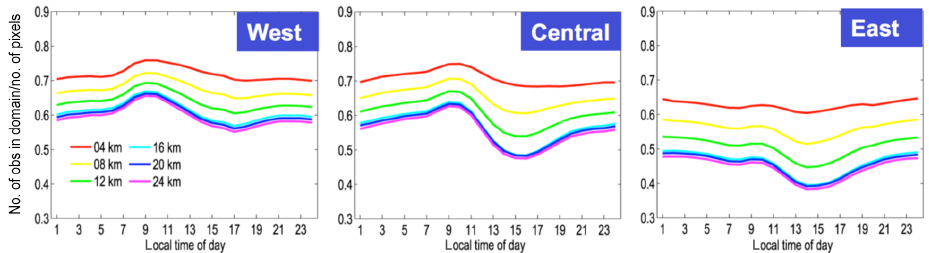
Figure 11. CONUS cloud statistics from OSSE results for 15–30 July 2006 using a high-spatial-resolution WRF-Chem run and a GFCR instrument with allowable pixel cloud fraction set at 3%. For different geographical regions, the fraction of cloud-free scenes (the number of cloud-free pixels observed as a fraction of the total number of pixels in the region) is plotted for different assumed pixel sizes; red represents the CHRONOS 4km × 4km pixels. Clouds are defined by 4km grid-integrated total hydrometeors >10 − 8 kgkg − 1 .